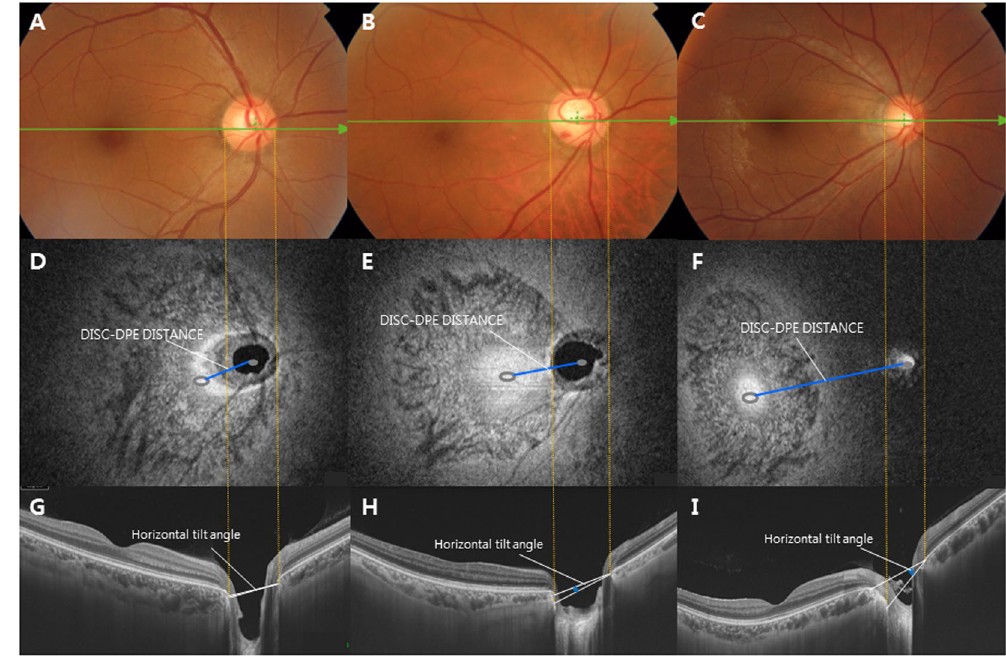
Figure 3. Disc photograph ( A – C ) and C-scan images ( D – F ) and B-scan images ( G – I ) of three different subjects with different disc to the deepest point of the eyeball (DPE) distances. As Disc-DPE distance elongated ( D – F ), the horizontal tilt angle significantly enlarged.